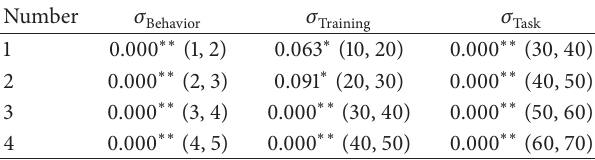
Table 5: Statistical significance of different